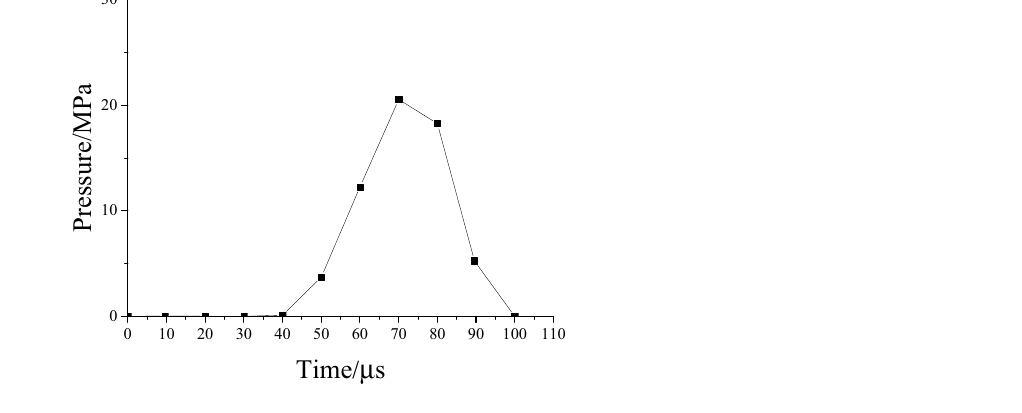
Figure 4. Explosion pressure versus time history curve.